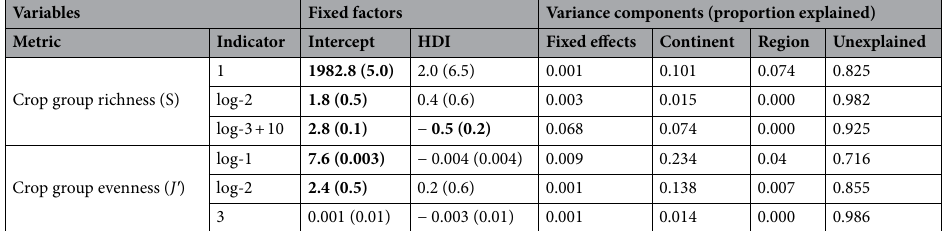
Table 3. Results and variance components predicting Indicators of crop group diversity ( S ) and evenness ( J ′ ) change, as a function of Human Development Index (HDI), continent identity, and region identity. In these models an intercept and slope related to HDI were included as fixed effects, while region within continent were included as nested random effects. Statistically significant ( p < 0.05) fixed effect model parameters are highlighted in bold, and data transformations (based on distribution fitting) precede the Indicator numbers (as per Figs. 2 and